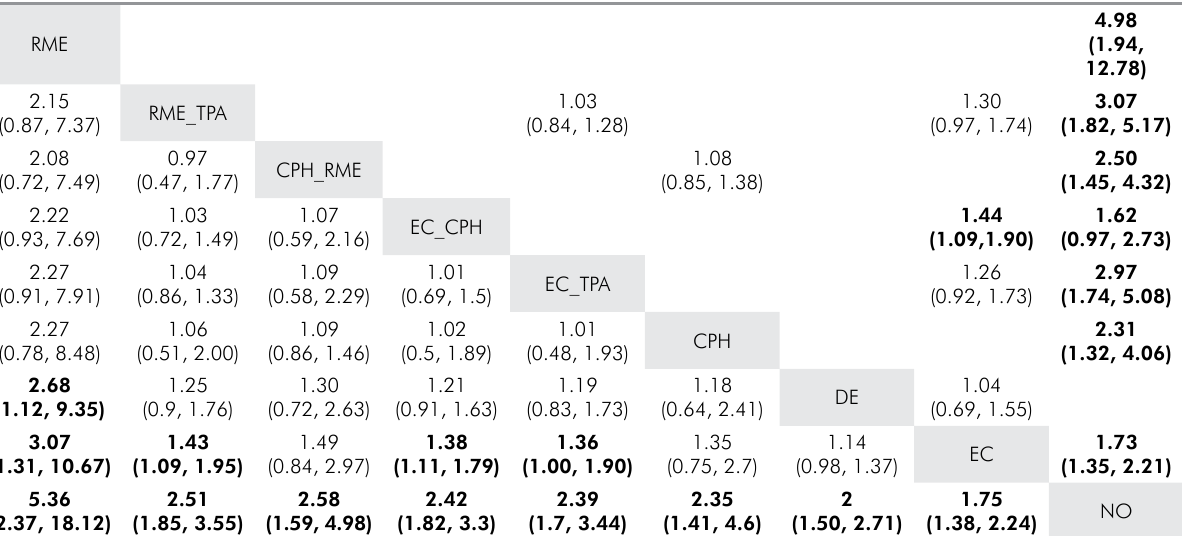
Table 5. Summary of results from network meta-analysis (on the lower triangle) and traditional pairwise meta-analysis (on the upper triangle) on clinical outcome.